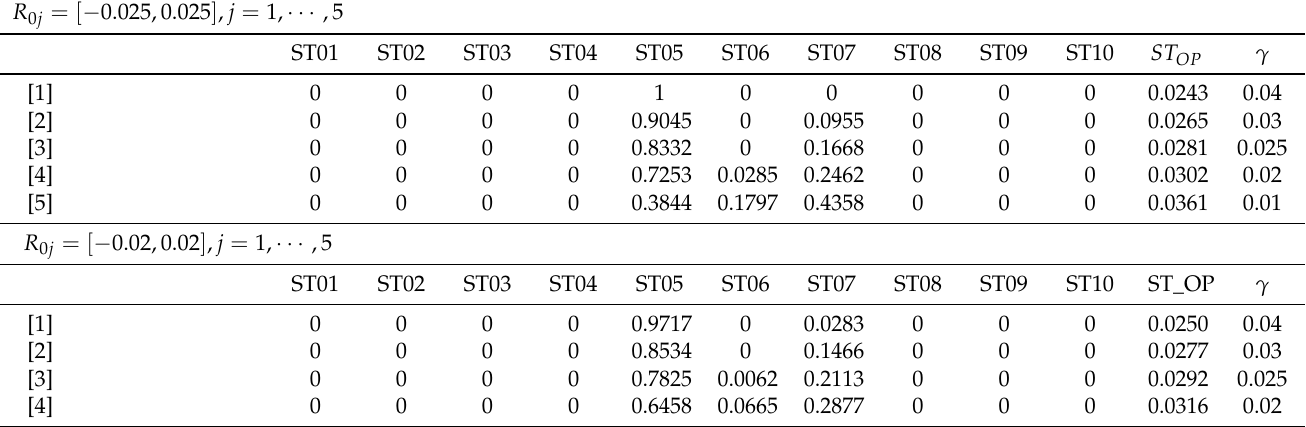
Table 4. Portfolio, Model 2 with the same R 0 j , j = 1, · · · ,5.